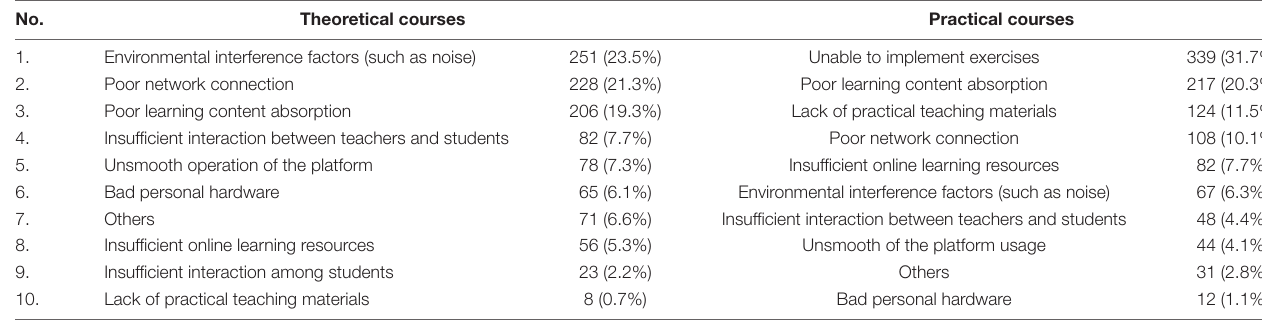
TABLE 6 | External factors affecting the learning quality of online